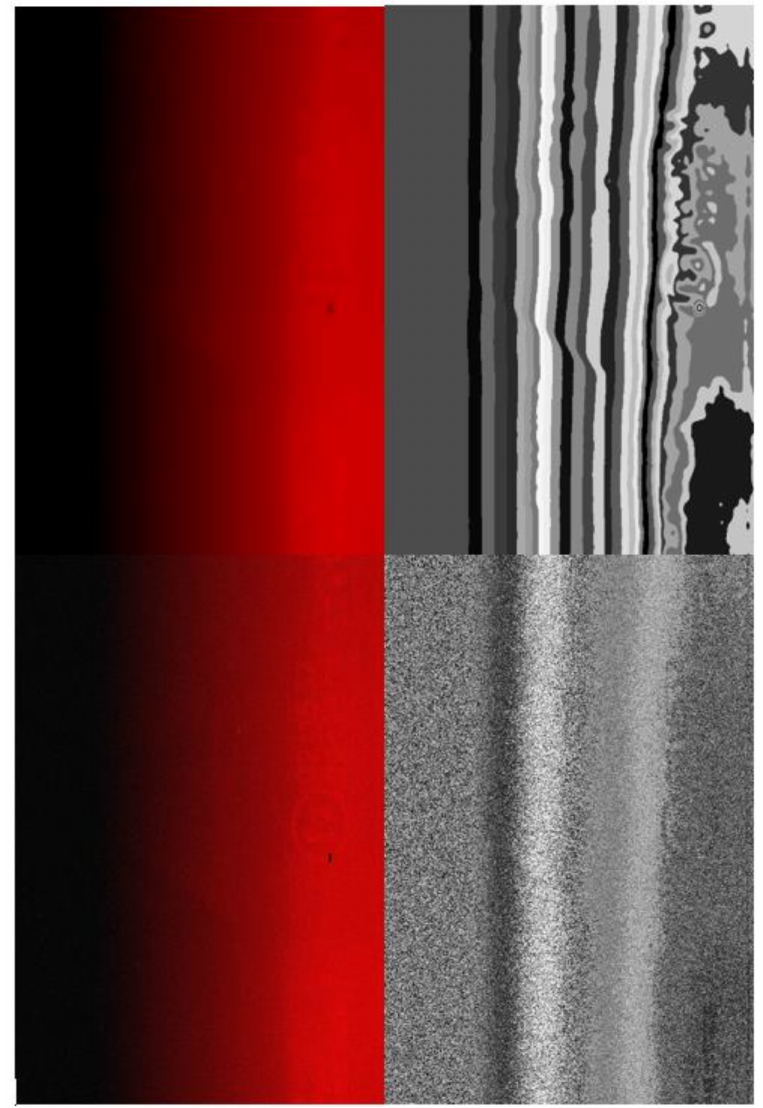
Figure 11. K-Means image processing of noisy images with (top) Gaussian blurring and (bottom) white noise with a dispersion factor of 8